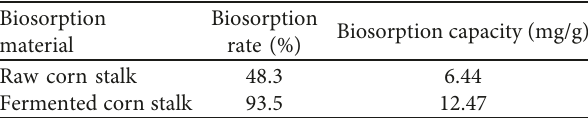
Table 1: Comparison of the biosorption of Cu 2+ by different dry modified materials.